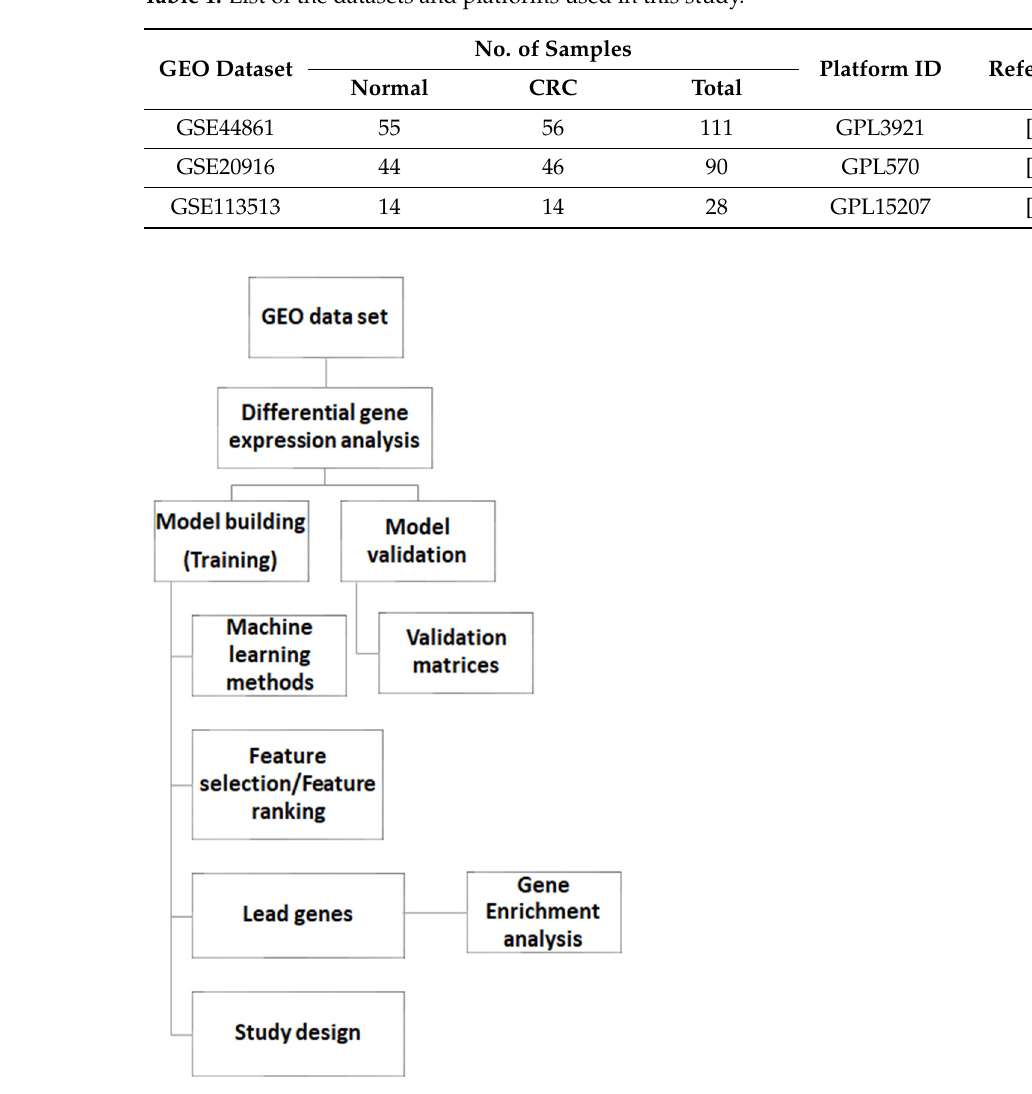
Table 1. List of the datasets and platforms used in this study.